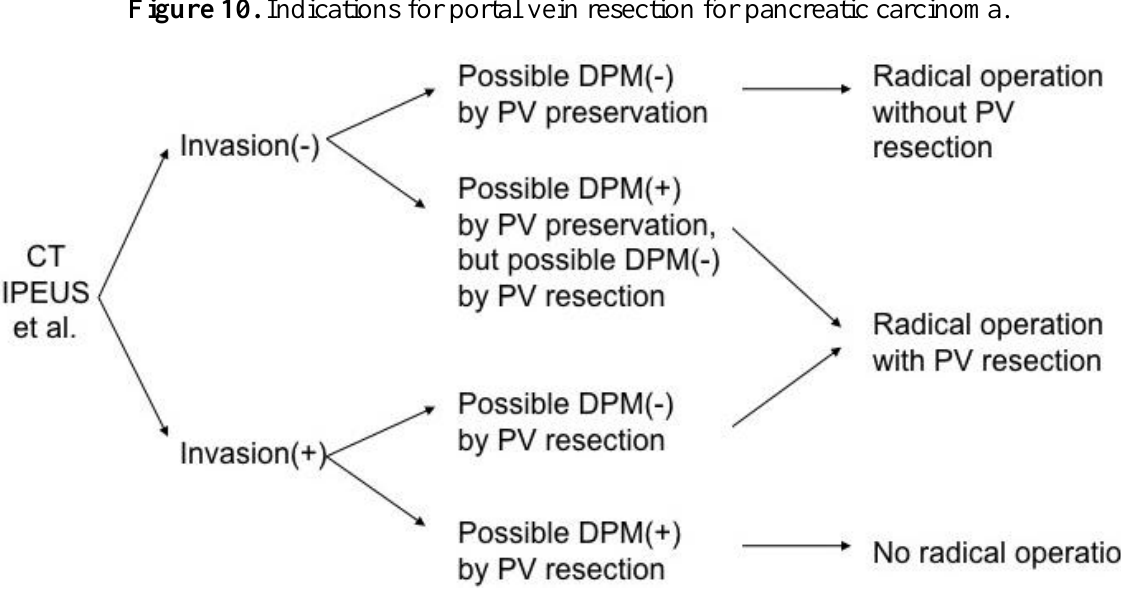
Figure 10. Indications for portal vein resection for pancreatic